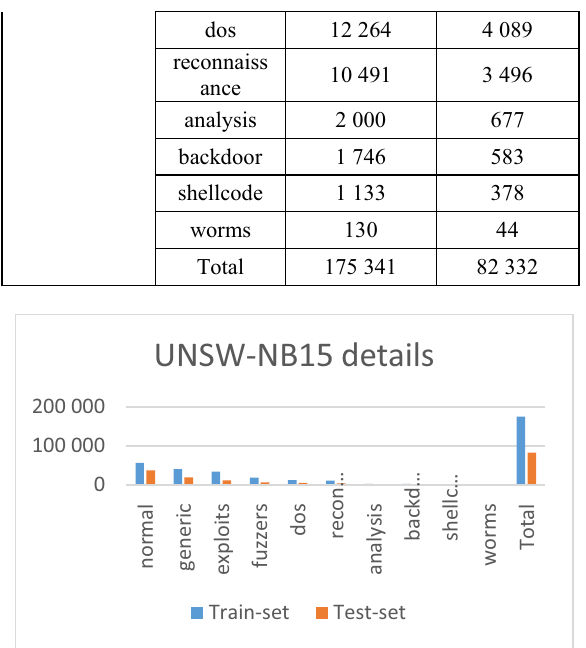
Fig. 1. UNSW-NB15 details